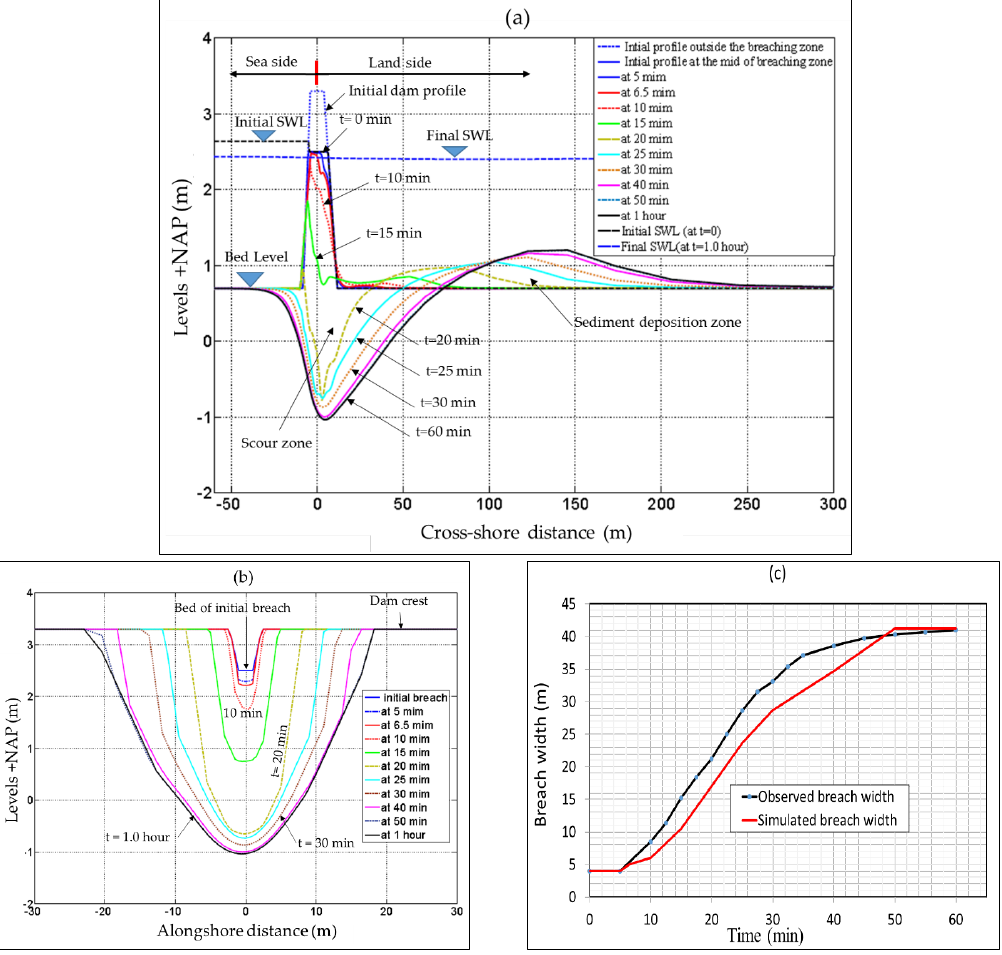
Figure 18. Reproduction of Het Zwin breach by XBeach: ( a ) breach development in cross-shore direction, ( b ) breach development in longshore direction and ( c ) simulated vs observed breach width evolution.